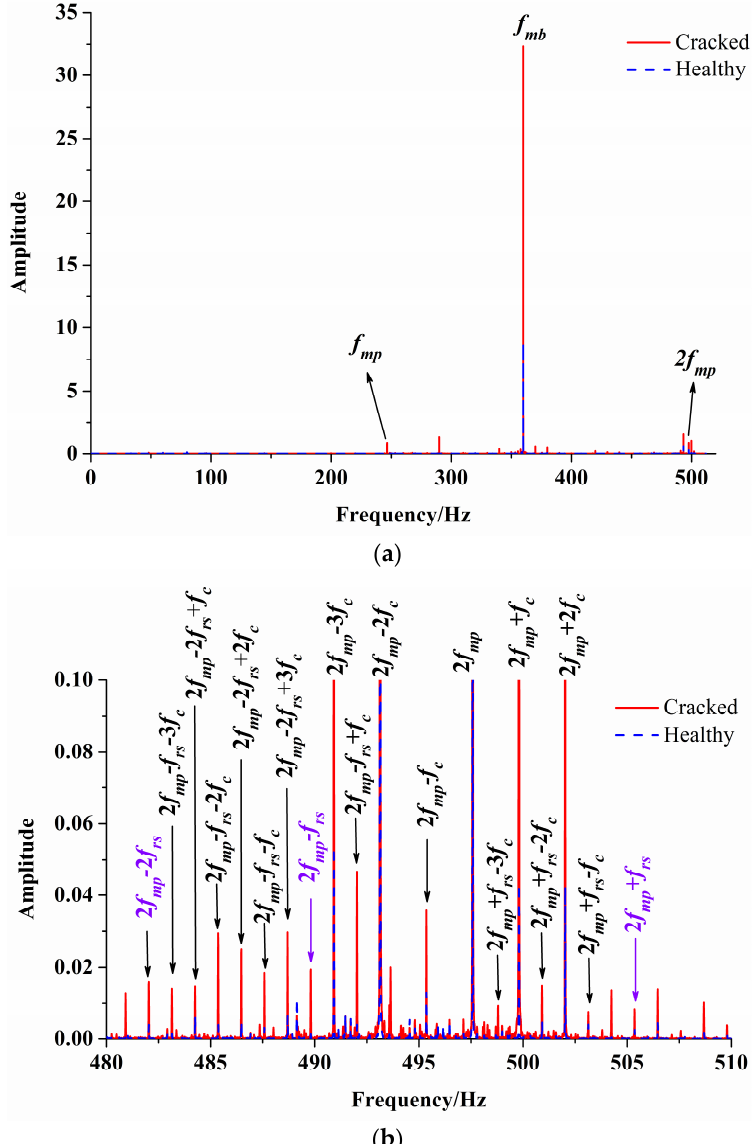
Figure 23. Vibration frequency spectrum of the experimental test rig of the gear transmission system: ( a ) full image; ( b ) partial enlarged view.